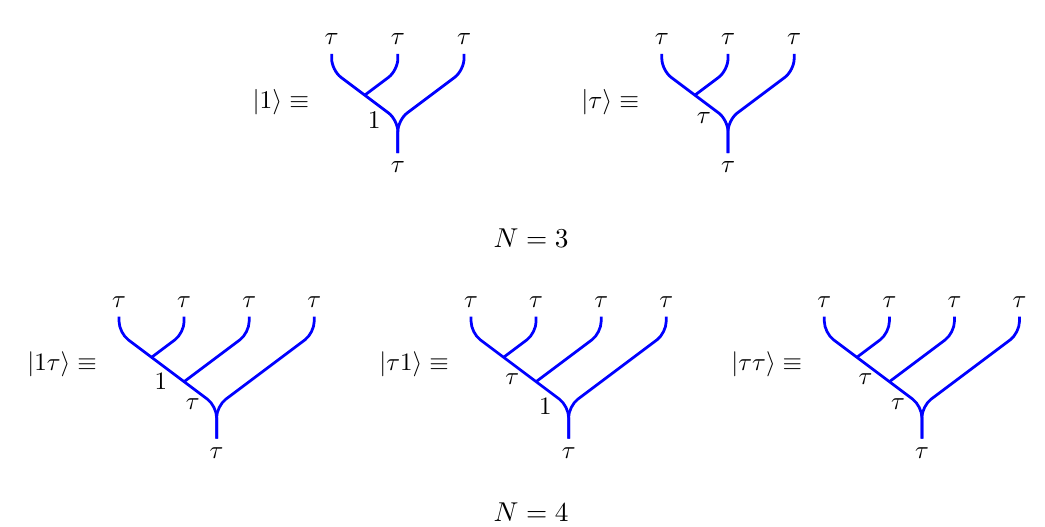
Figure 6 . Fusion basis resulting from the fusion of N = 3 and N = 4 Fibonacci anyons. Forbidden Allowed 11 1 τ , τ 1 , ττ Table 4 . The forbidden and allowed configurations in the basis states of Fibonacci